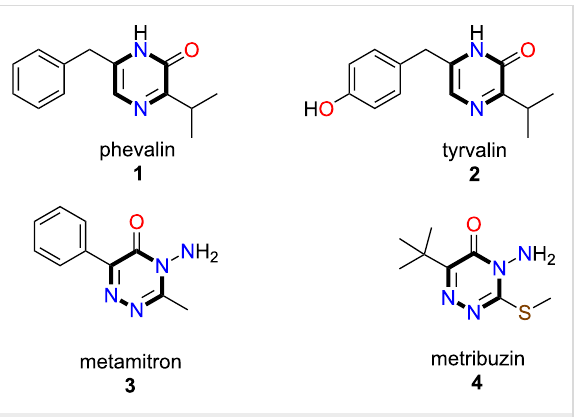
Figure 1: Structures of some natural products containing pyrazinone and aminotriazonone skeletons.